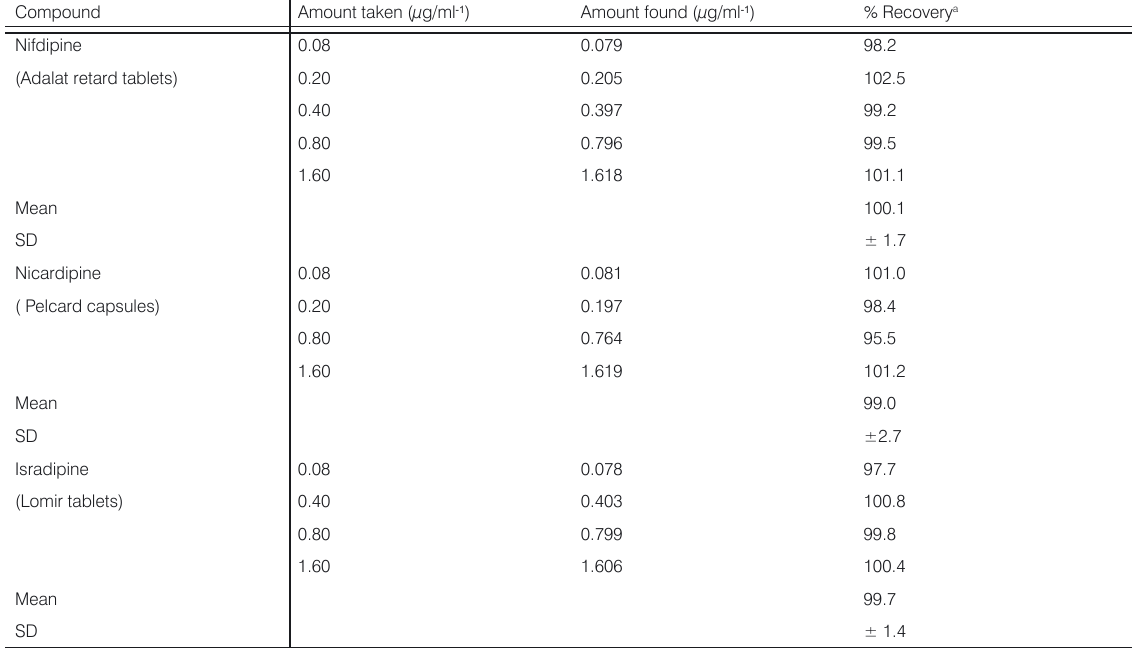
Table 3. Application of the proposed spectrofluorimetric determination of studied compounds in their